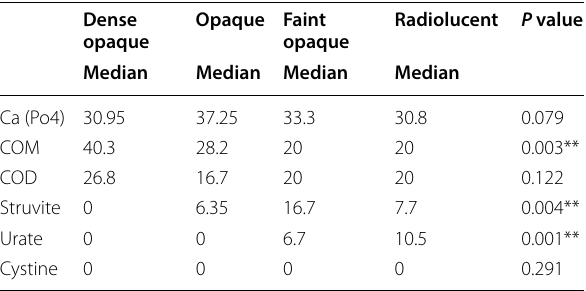
Table 1 Distribution of mixed stones Stone type